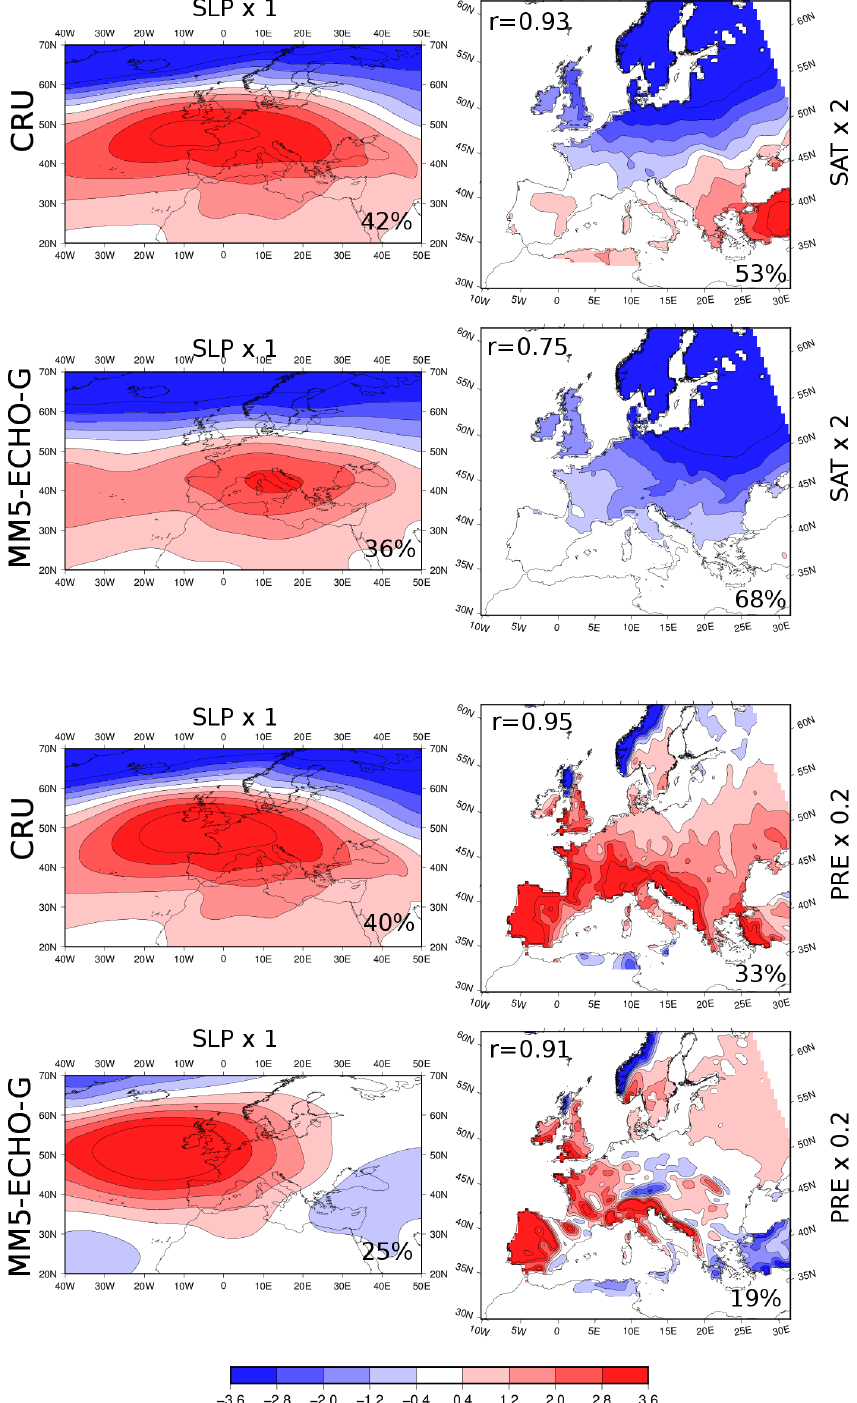
Figure 10. Canonical correlation pattern pairs of SLP and SAT (rows 1 and 2) and SLP and precipitation (rows 3 and 4) in winter. Each panel depicts the percentage of variance explained by each pattern and the canonical correlation associated with the pair. The results are calculated in the observational record (rows 1 and 3) and in the MM5-ECHO-G data set (rows 2 and 4) during the period 1901–1990. Note that the SLP has been obtained directly from the driving GCM, since the window of interest lies outside the RCM domain. As in Figs. 8 and 9, the patterns have been multiplied by a scaling factor that allows using the same colour scale in every map. The SAT unit is ◦ C, SLP is shown in Pa, whereas precipitation units are millimetres per